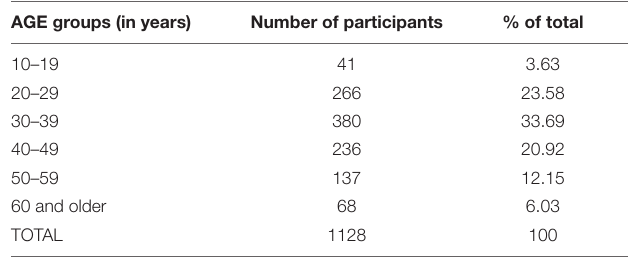
TABLE 2 | Number of participants in each age group and percent of